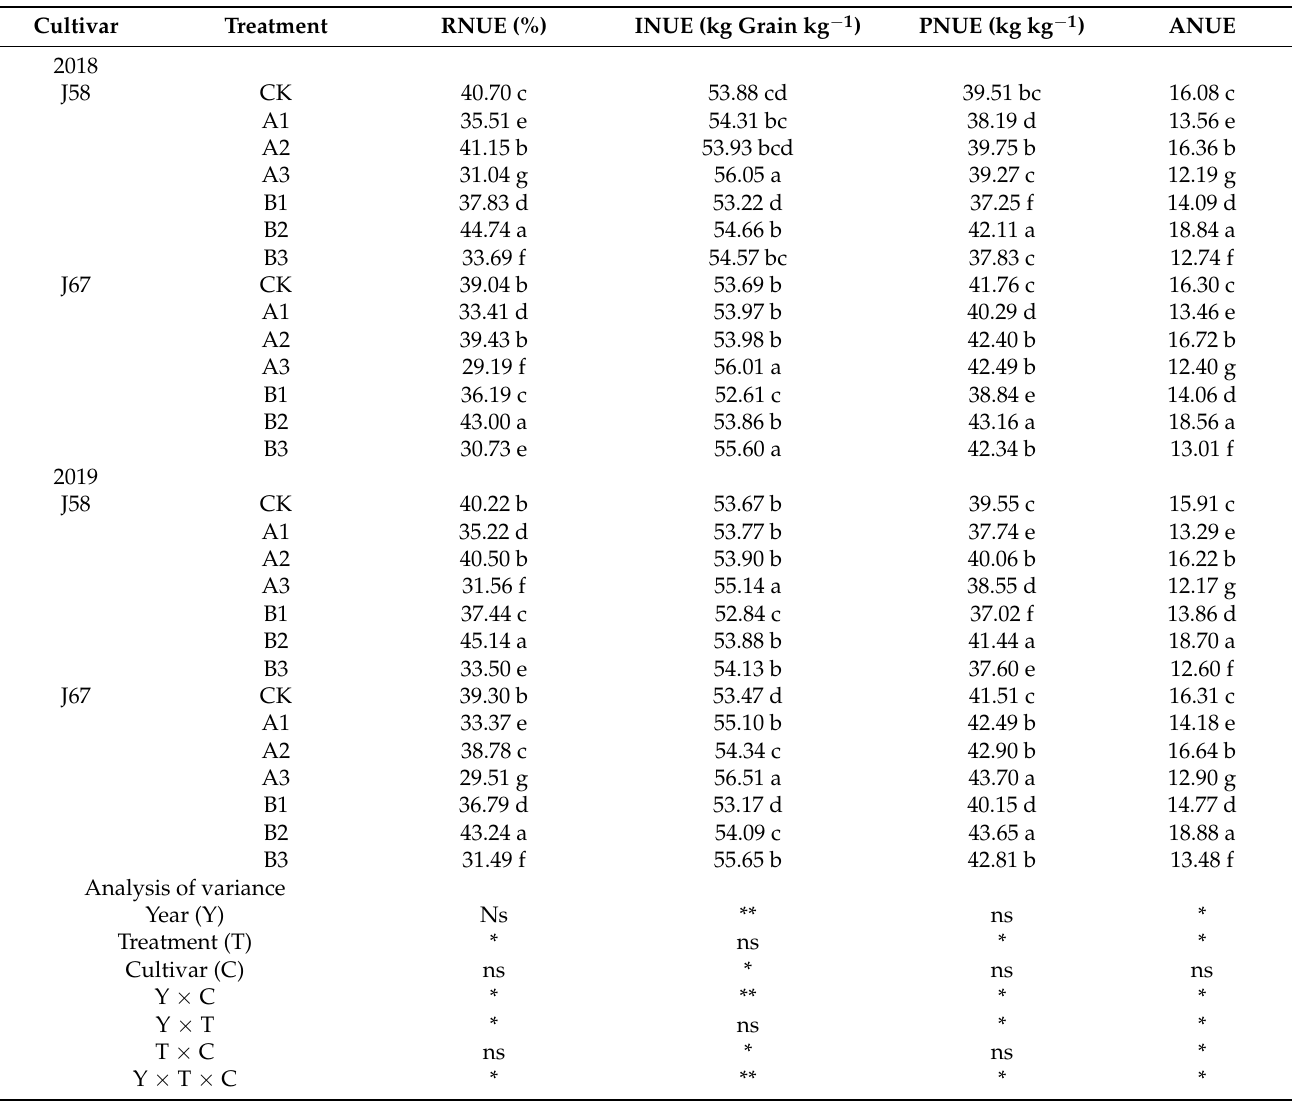
Table 8. Differences in N-utilization efficiency 3